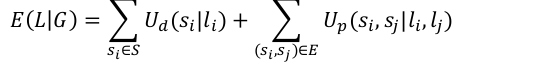
Figure 6: (a) Thermal images before relative thermographic calibration and (b) after.